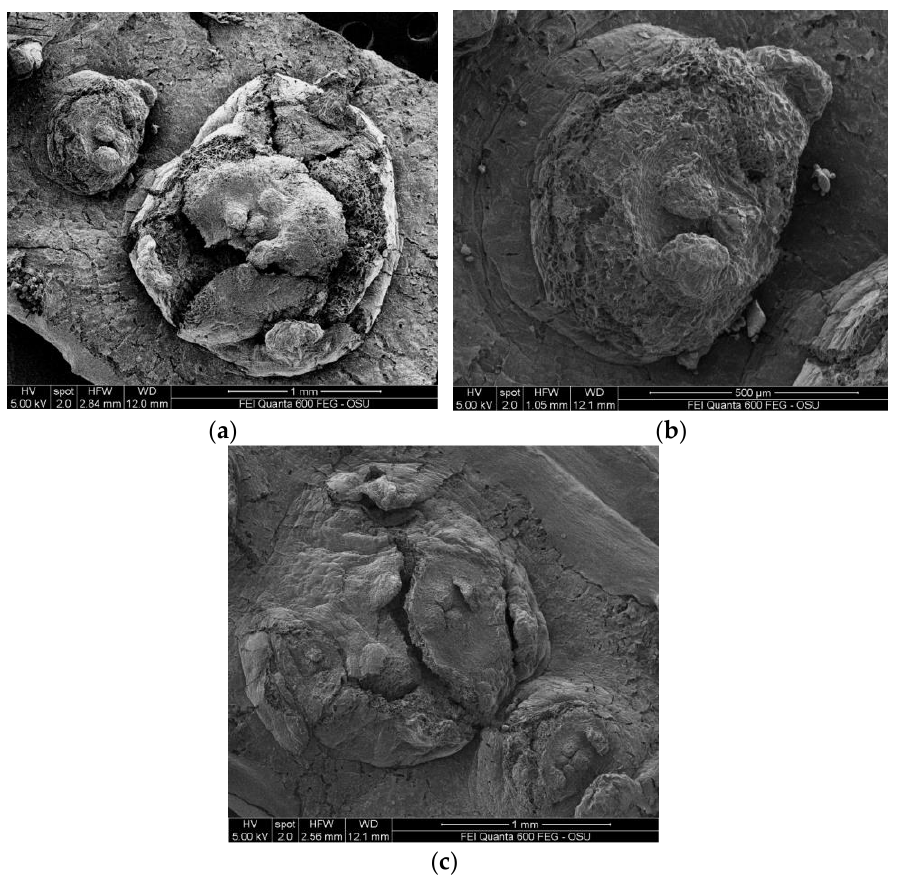
Figure 3. Ranger Russet tubers treated with ( a ) Cymbopogon citratus essential oil (EO) and ( b ) distilled water at 90 days of storage.